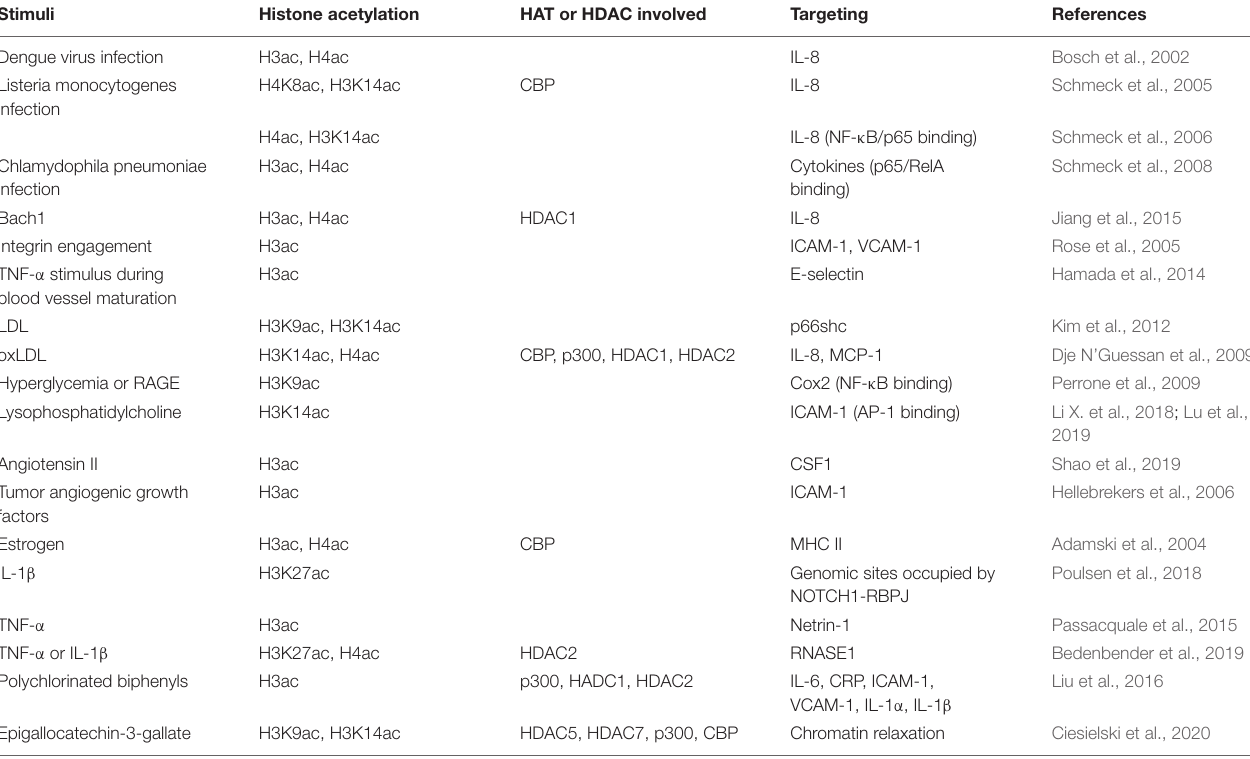
TABLE 2 | Inflammation signals mediated by histone acetylation in